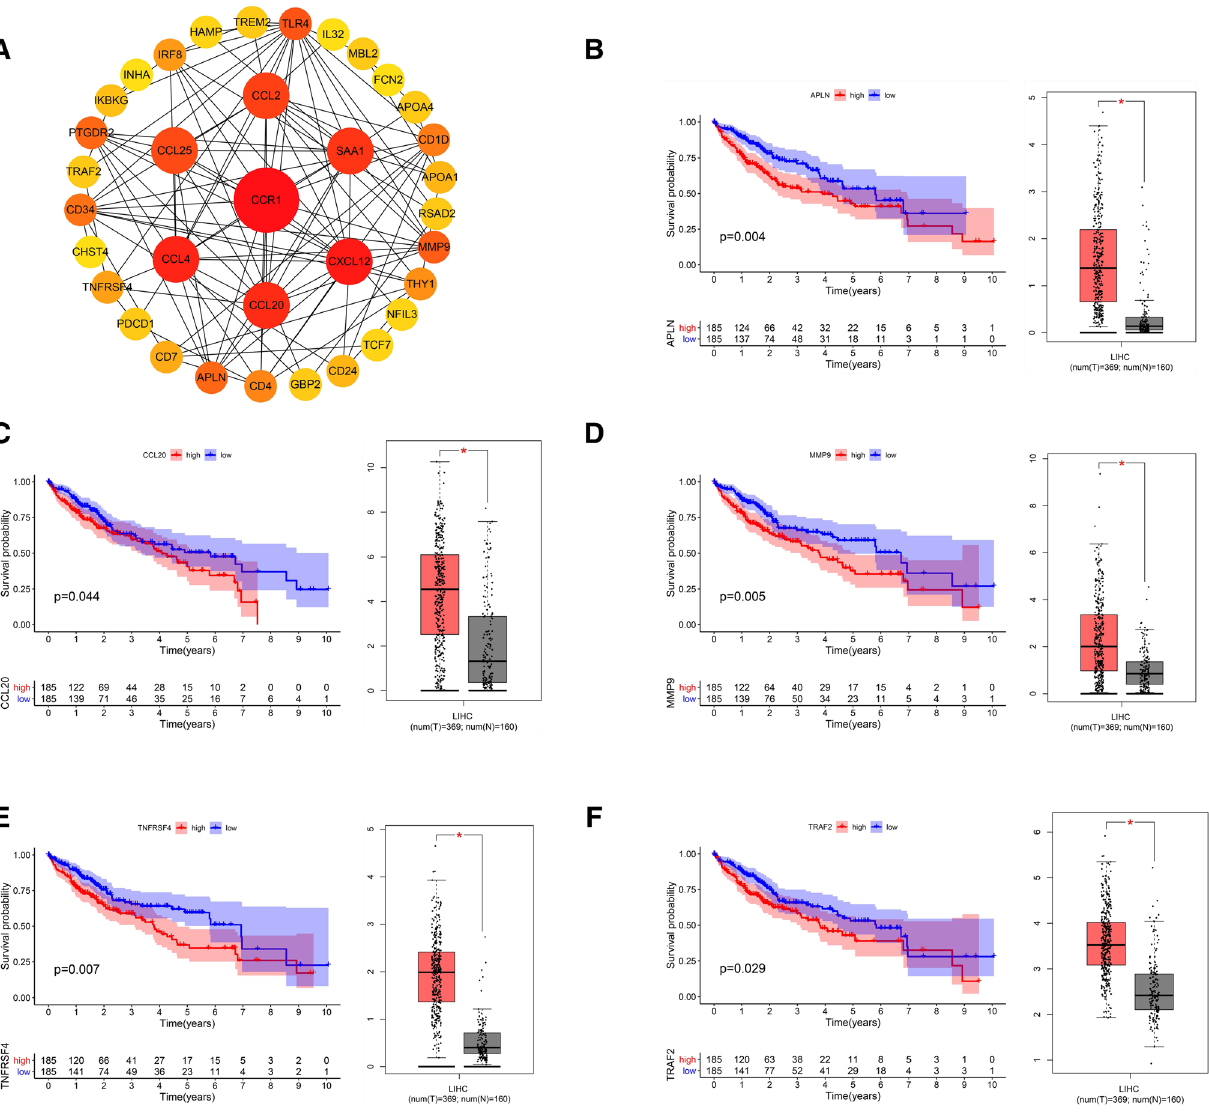
Fig. 2 mRNAs with significant differential expression and prognostic implications in HCC. a Protein network diagram of Immune-DEmRNAs. Differential expression and survival analysis of APLN ( b ), CCL20 ( c ), MMP9 ( d ), TNFRSF4 ( e ), and TRAF2 ( f ) in HCC (*P <